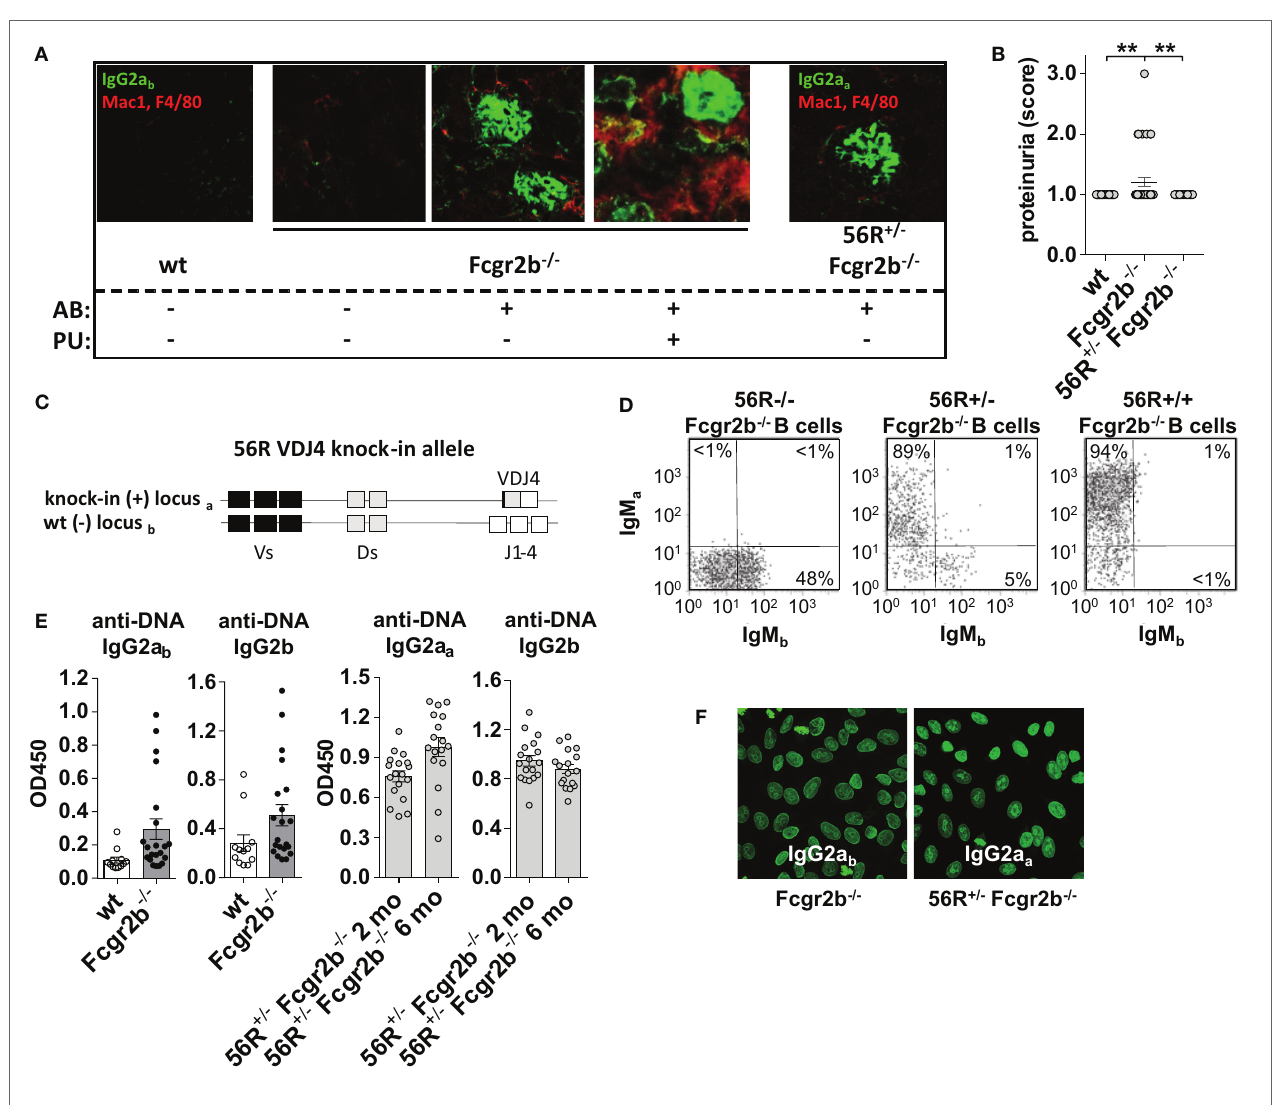
FigUre 1 | 56R + / − Fcgr2b − / − mice develop self- and polyreactive IgG2a and IgG2b autoantibodies (autoAbs) earlier than Fcgr2b − / − but show no signs of renal inflammation. (a) Indirect immunofluorescence analysis of IgG2a immune complex (IC) depositions and macrophage infiltration in kidney sections from 6-month- old wt mice, IgG autoAb (AB)-negative and proteinuria (PU)-negative (AB − PU − ), AB + PU − and AB + PU + Fcgr2b − / − mice (all IgG2a b ) and 56R + / − Fcgr2b − / − mice (IgG2a a ). The presented immunofluorescence images are representative of at least five mice per group. (B) PU scores for 5–6-month-old wt ( n = 30), Fcgr2b − / − ( n = 39) and 56R + / − Fcgr2b − / − ( n = 30) mice. Each data point represents an individual animal; horizontal lines represent mean values. (c) Schematic representation of the self- and polyreactive 56R VDJ4 knock-in (haplotype a) and the wt (haplotype b) heavy chain loci. The 56R VDJ4 knock-in replaced the endogenous IgH Js and can class-switch to all Ab isotypes (43–46). (D) The frequencies of B220 + B cells expressing the knock-in allele (a) or the wt allele (b) were analyzed by flow cytometry of splenocytes from 2-month-old 56R − / − , 56R + / − or 56R + / + Fcgr2b − / − mice. About 5–10% of B cells in 56R + / − Fcgr2b − / − mice expressed the wt (IgM b + ) BCR. (e) Anti-DNA IgG2a b , IgG2b or IgG2a a subclass Abs in sera of 5–7-month-old wt and Fcgr2b − / − mice and 2- or 6-month-old 56R + / − Fcgr2b − / − mice were determined via enzyme-linked immunofluorescence assay. Each data point represents an individual animal. Bars indicate mean values. (F) IgG2a b and IgG2a a Ab binding to HEp-2 slides from sera of 6-month-old Fcgr2b − / − and 56R + / − Fcgr2b − / − mice,